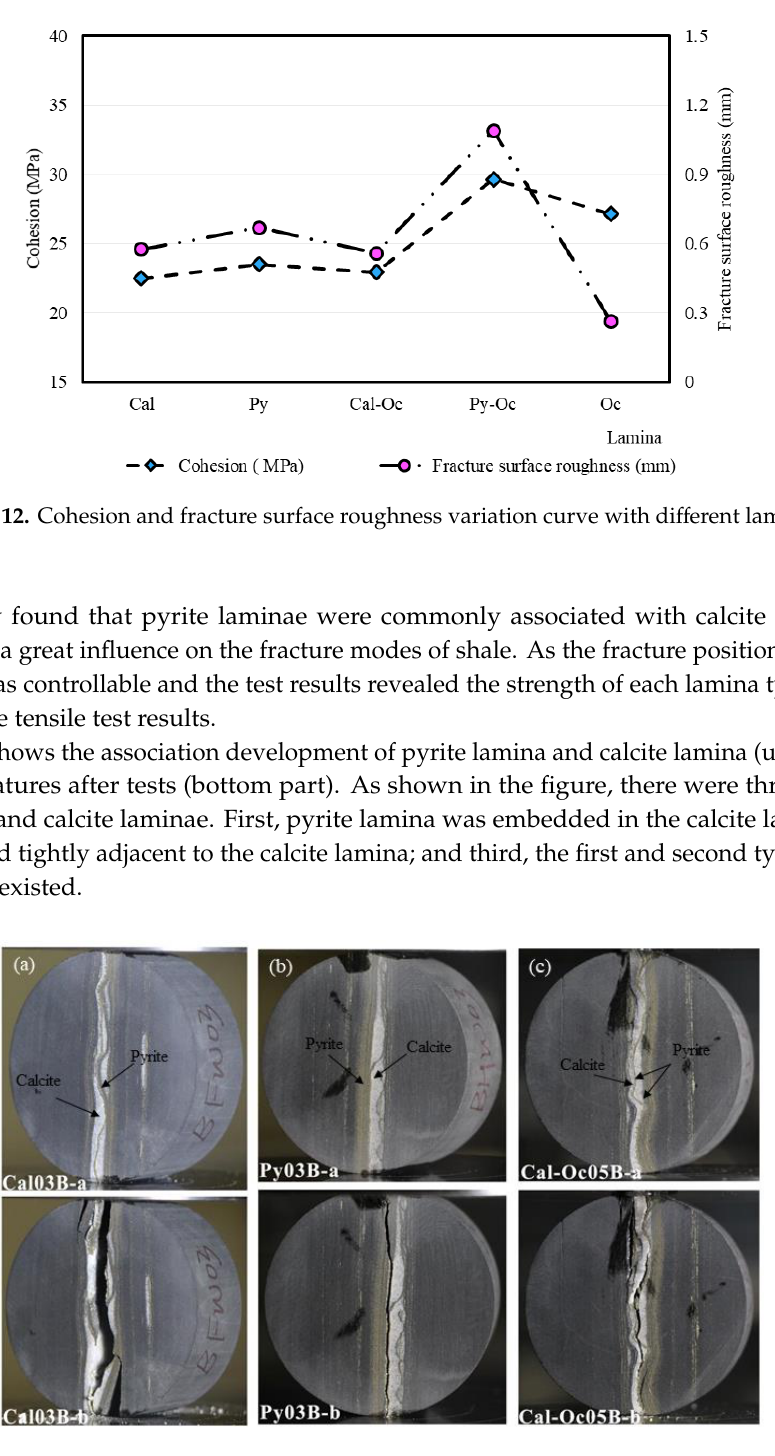
Table 4. Variation in fracture surface roughness parameters of the Longmaxi Shale laminae.